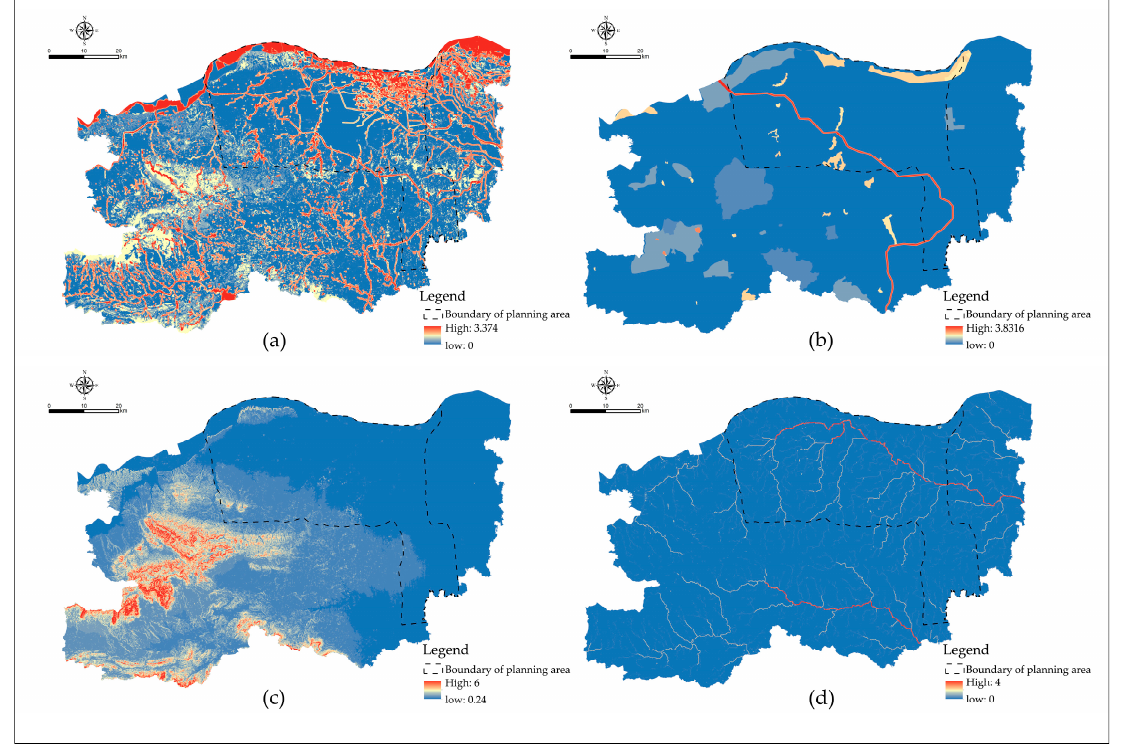
Figure 3. Individual layers of factors evaluation of water ecological sensitivity: ( a ) Sensitivity evaluation of existing water ecological factors; ( b ) Sensitivity evaluation of significant water safety factors; ( c ) Sensitivity evaluation of indirect water environment factors; ( d ) Sensitivity evaluation of potential sponge body factors.